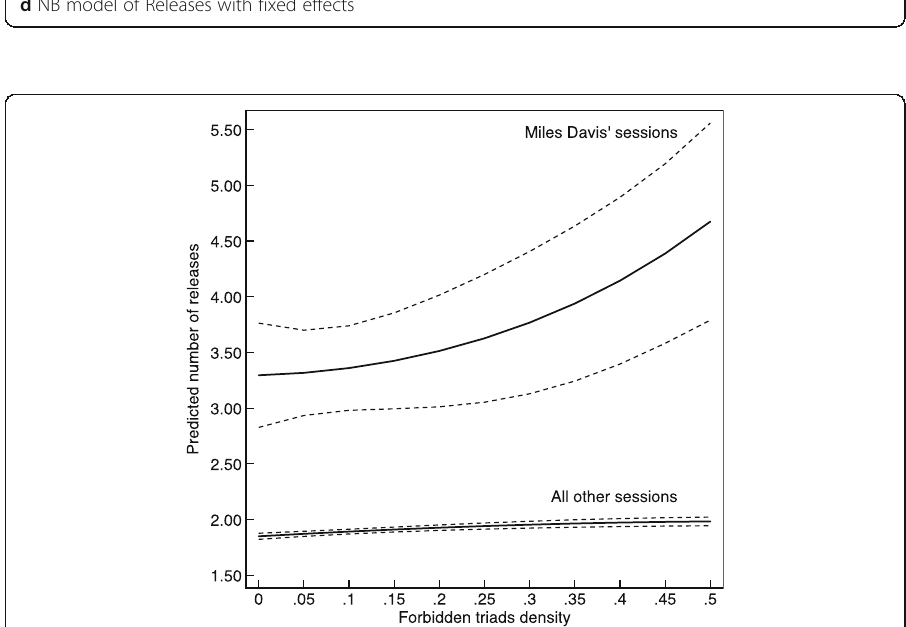
Fig. 9 Marginal effects plot for forbidden triads density in Miles Davis ’ sessions using the NB